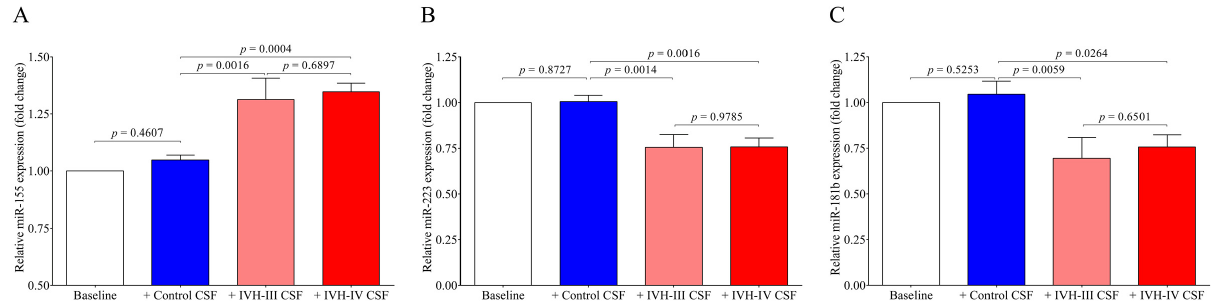
Figure 9. Intracellular expression of inflammation-specific miR-155 ( A ) was upregulated in response to the exposure of HCPEpiCs to IVH-III (light red column) or IVH-IV (red column) CSF samples for 24 h. Conversely, miR-223 ( B ) and miR-181b ( C ) levels were downregulated by the inflammatory stimulus compared to cells treated with non-IVH CSF samples (blue column). Mean ± SEM are depicted, n = 7–8/group. The ANOVA test with Bonferroni’s multiple comparison test was used for the comparisons. Abbreviations: CSF, cerebrospinal fluid; HCPEpiCs, human choroid plexus epithelial cells; IVH, intraventricular hemorrhage; and miRNA,